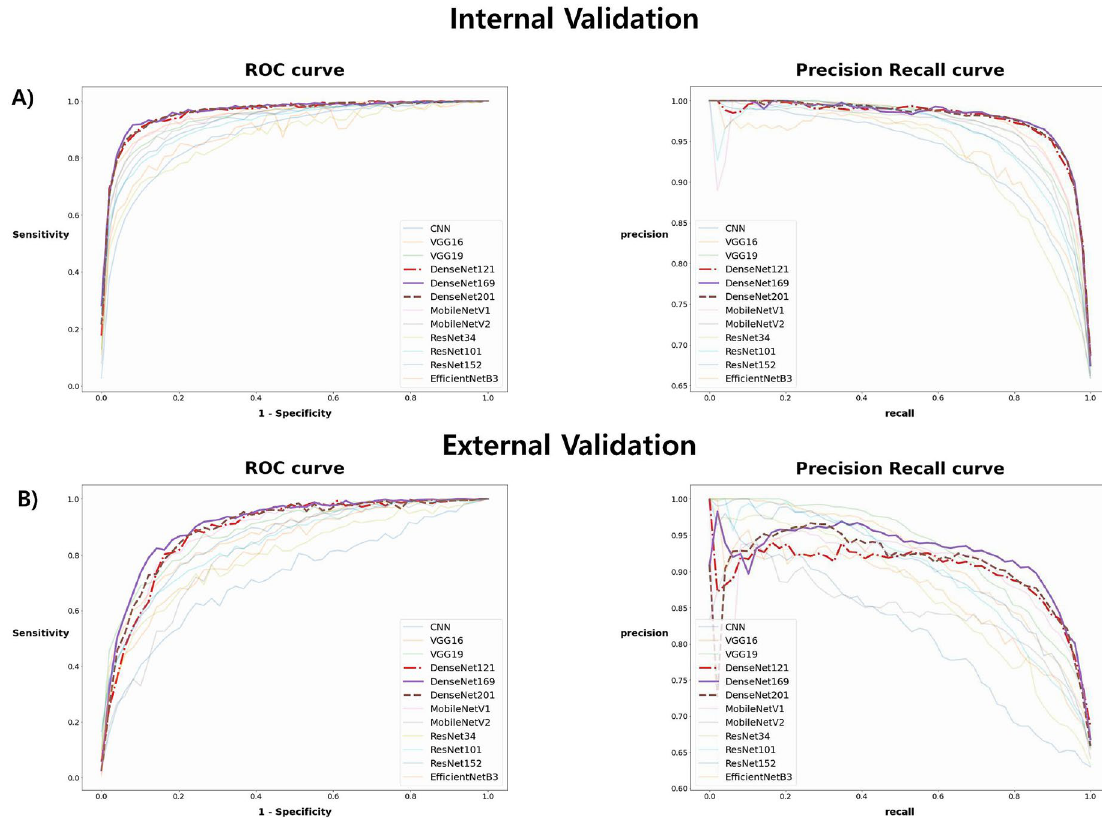
Figure 2. Receiver operating characteristic curves and precision-recall curves for the deep learning algorithm on internal validation dataset ( A ) and external validation datasets ( B ).